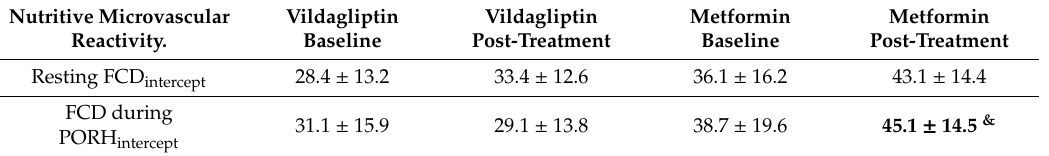
Table 3. E ff ects of vildagliptin and metformin on postprandial nutritive microvascular reactivity. Nutritive Microvascular Reactivity.